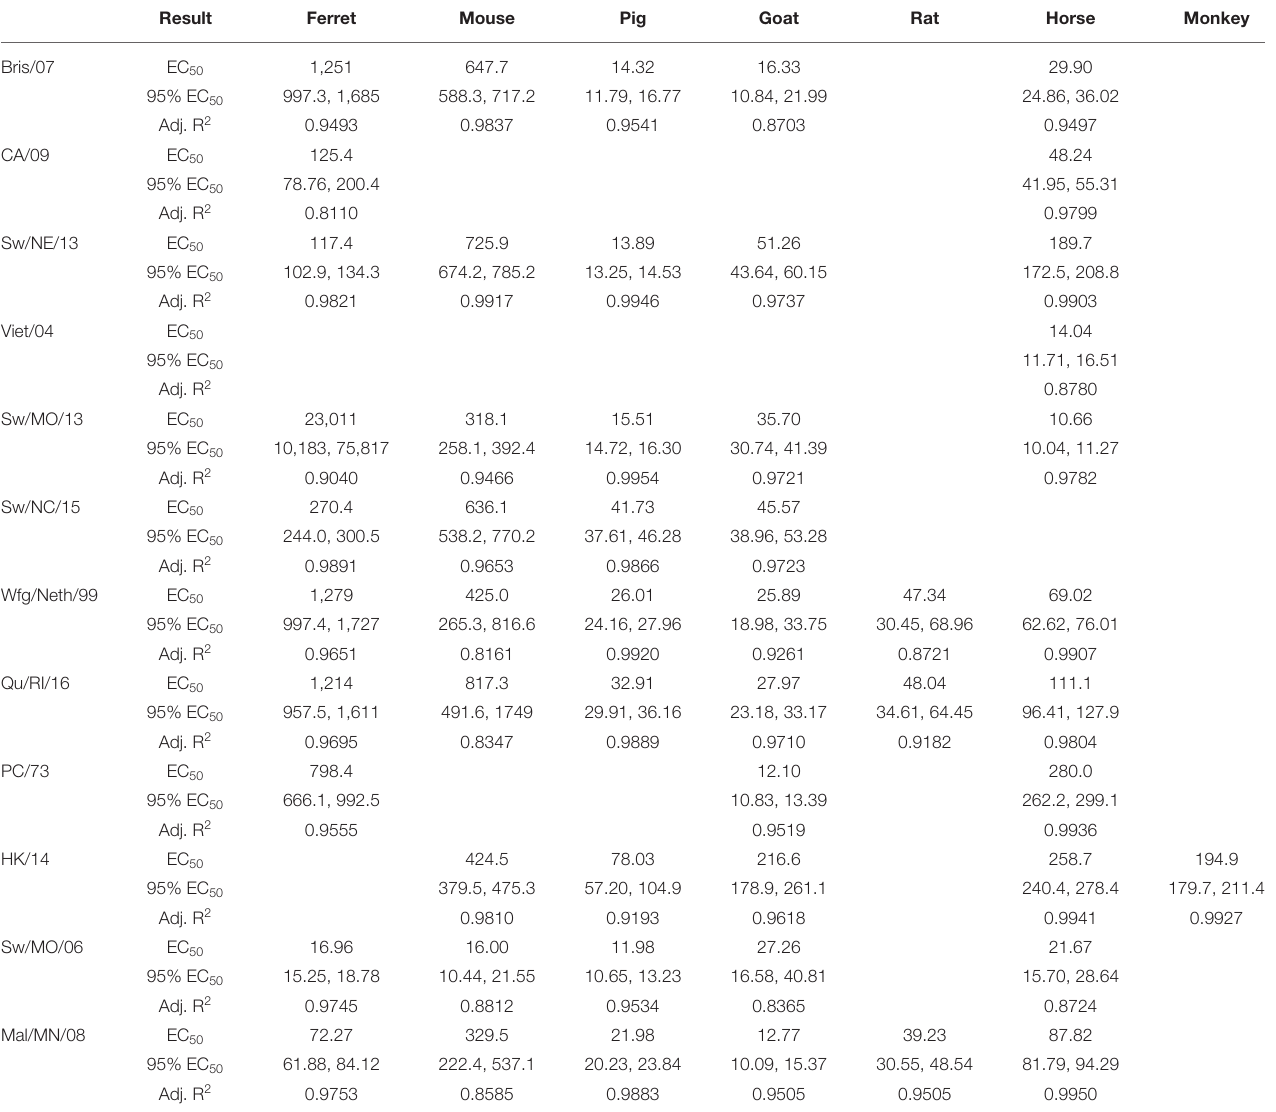
TABLE 2 | Non-linear regression fits of raw serum inhibition of Type A influenza viruses. Result Ferret Mouse Pig Goat Rat Horse